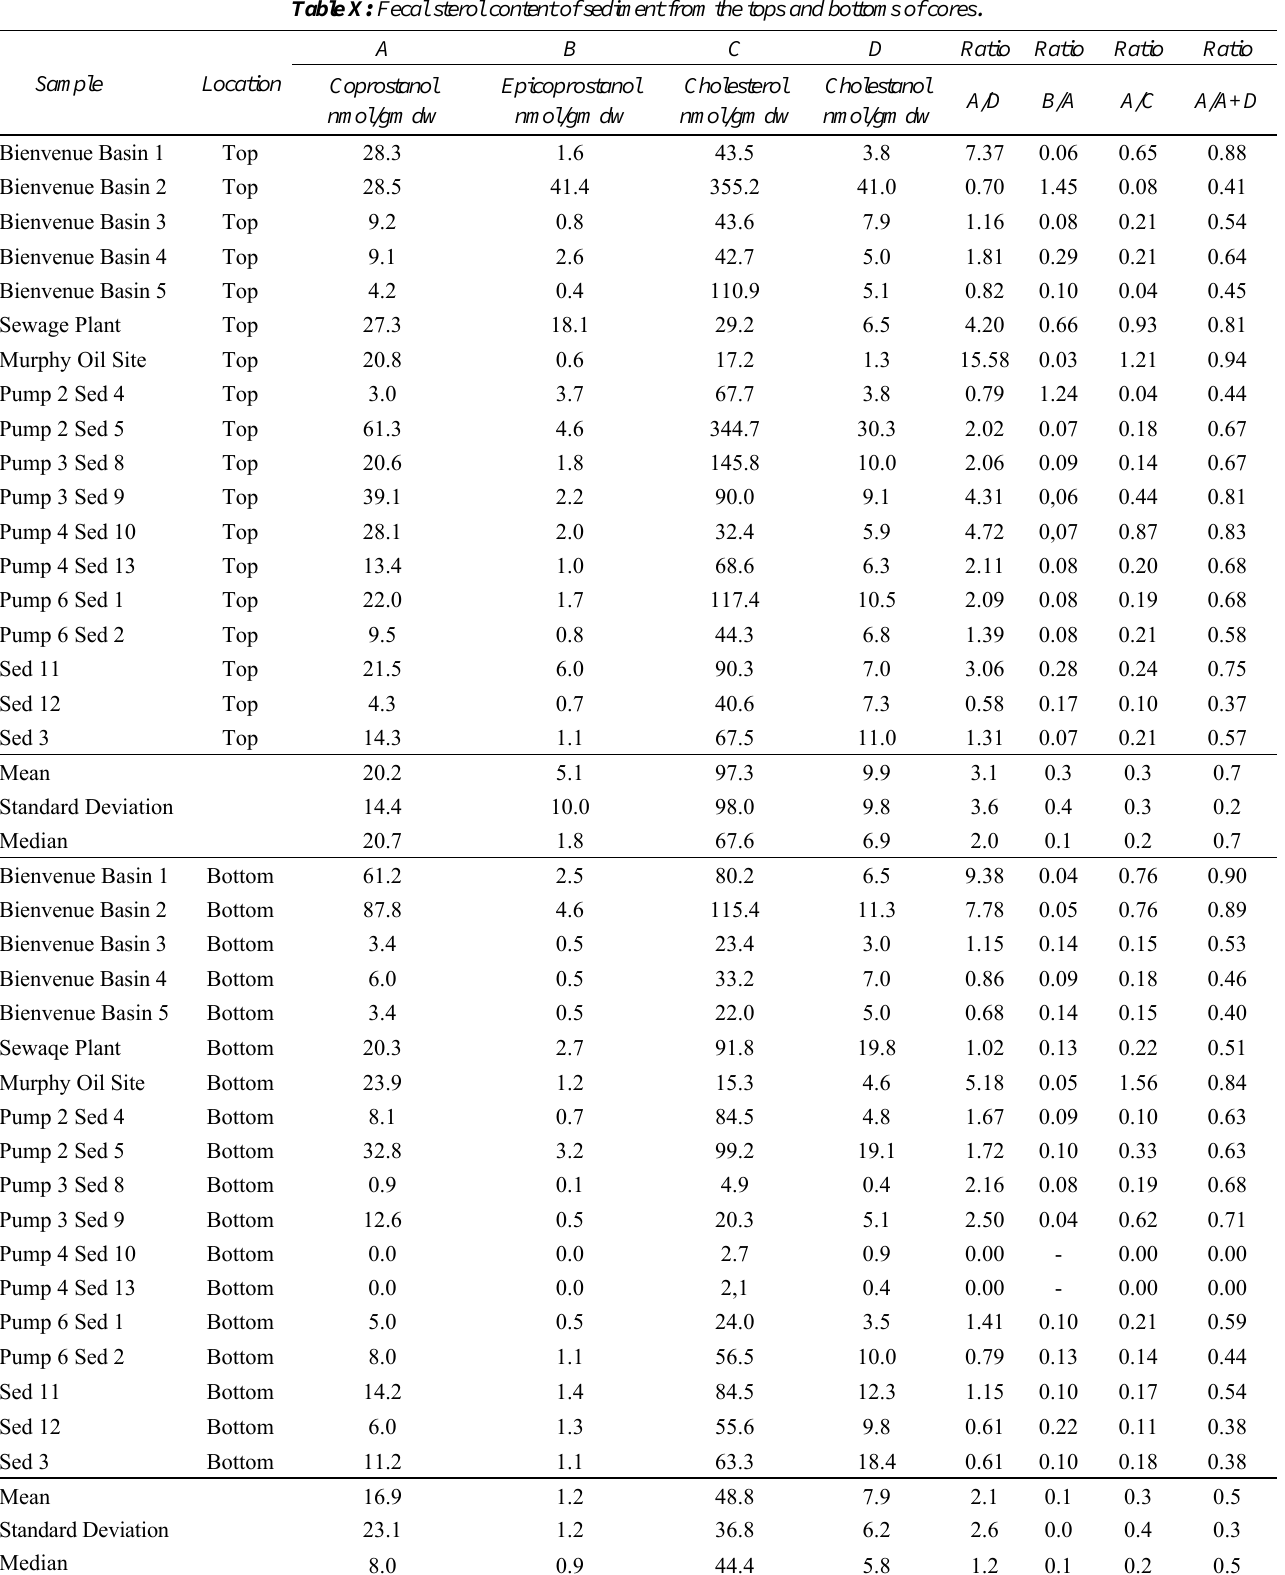
Table 3: Map illustrating the sediment core locations with respect to the sewage treatment plant and stations that pumped flood water over the levee and into Violet Marsh. The GPS coordinates for the core locations are given in Table 1. Table X: Fecal sterol content of sediment from the tops and bottoms of cores.